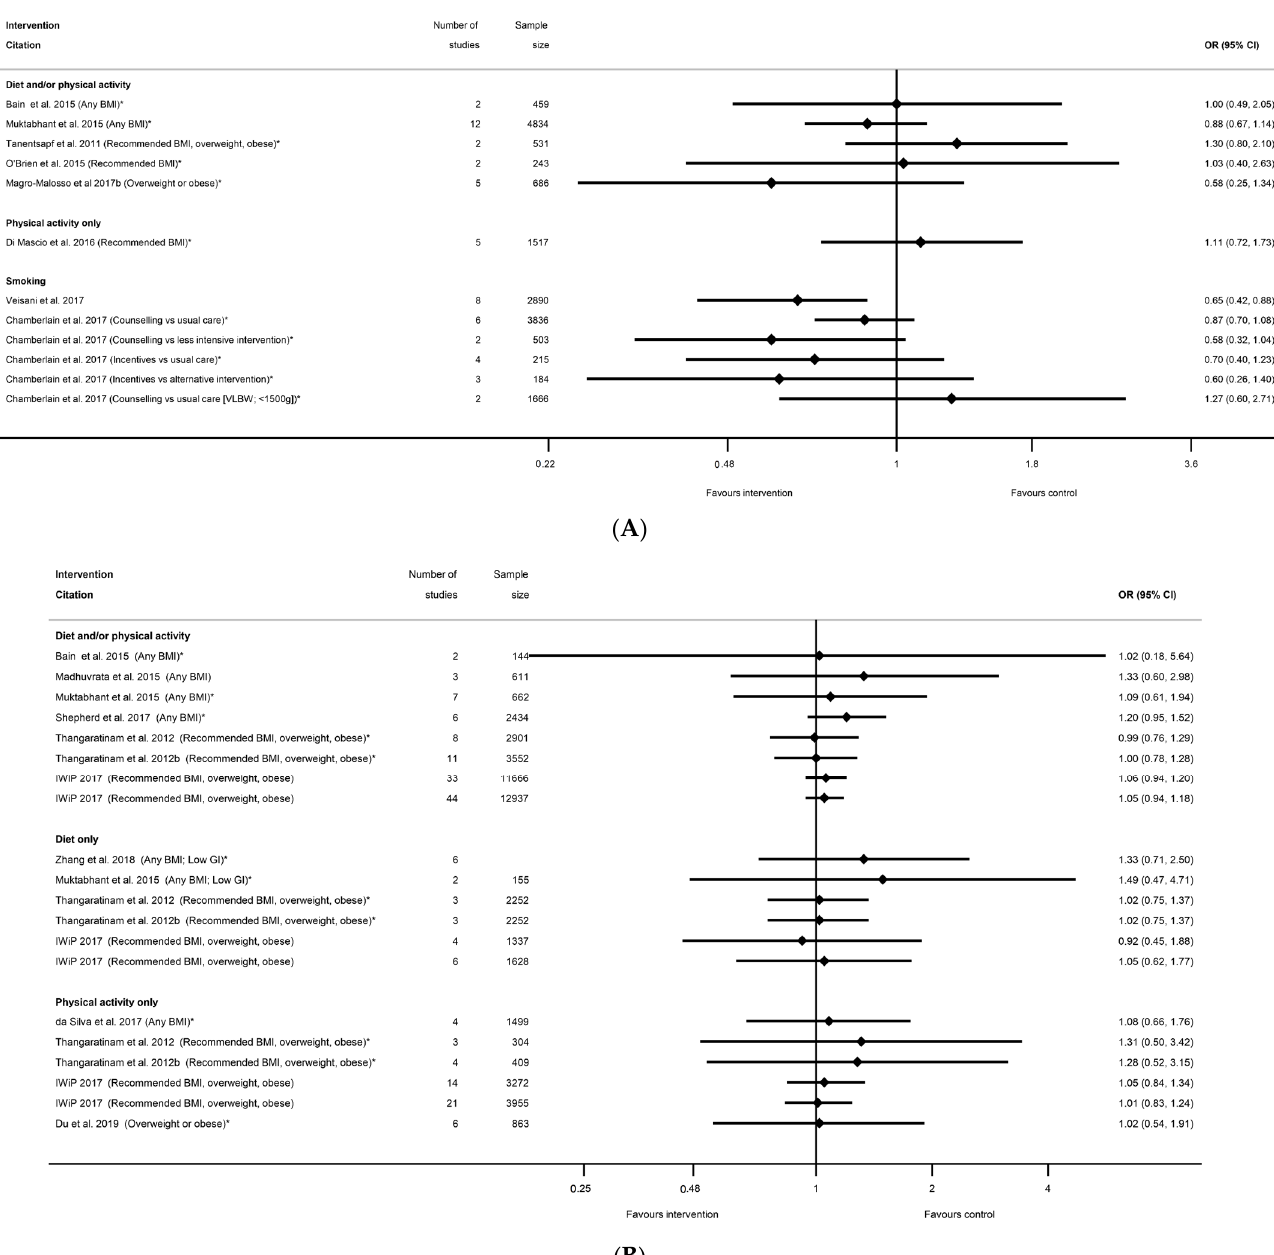
Figure 12. Forest plot of meta-analysis results for low-birthweight outcomes ( A ) LBW, ( B ) SGA. * indicates the estimate is relative risk.